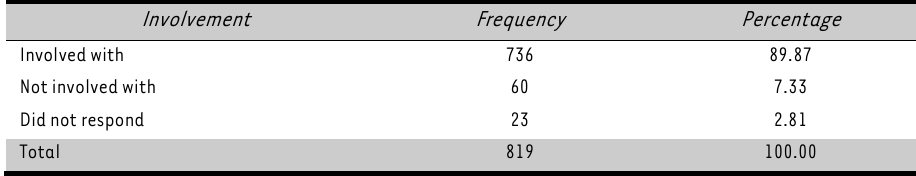
Respondents’ involvement with non-public